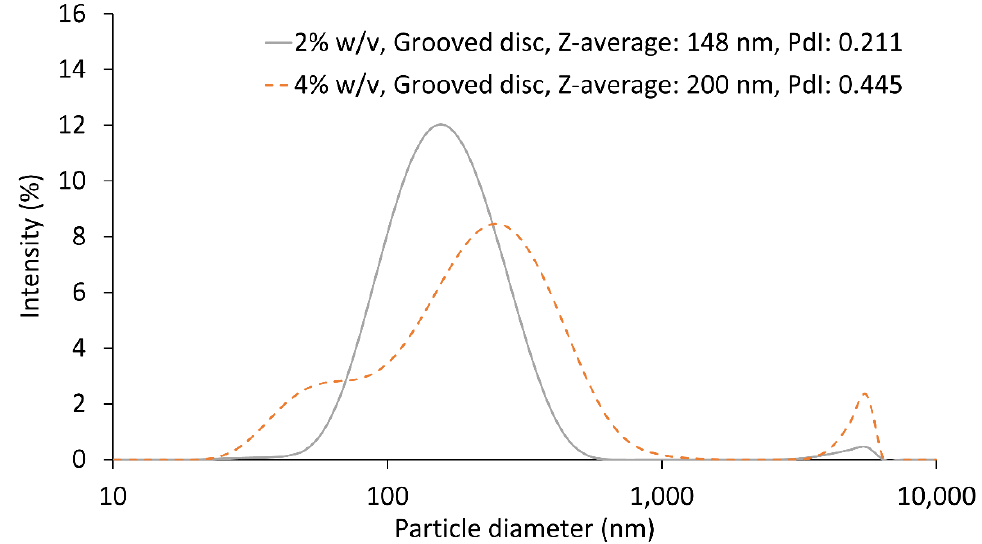
Figure 12. Overall PSD showing e ff ect of concentration at 18 mL / s, 1200 rpm, and 9:1 ratio on the grooved disc.